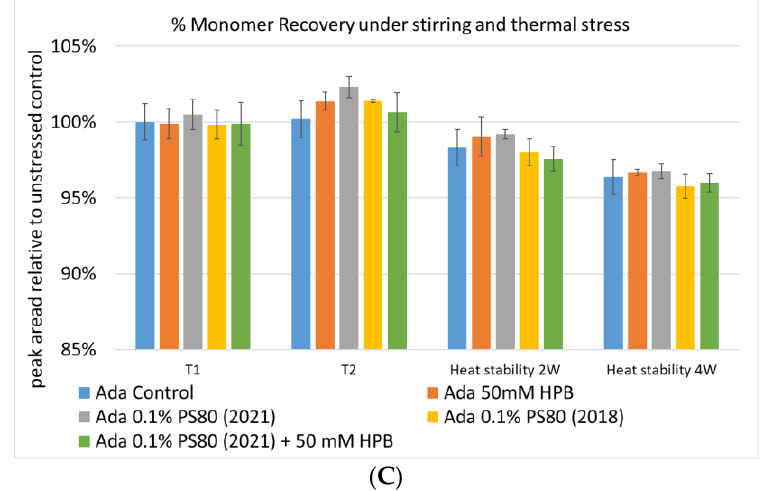
Figure 9. Fragmentation ( A ), aggregation ( B ), and monomer recovery ( C ) of adalimumab in different formulations under agitation in 2 hours and thermal stresses within 4 weeks.